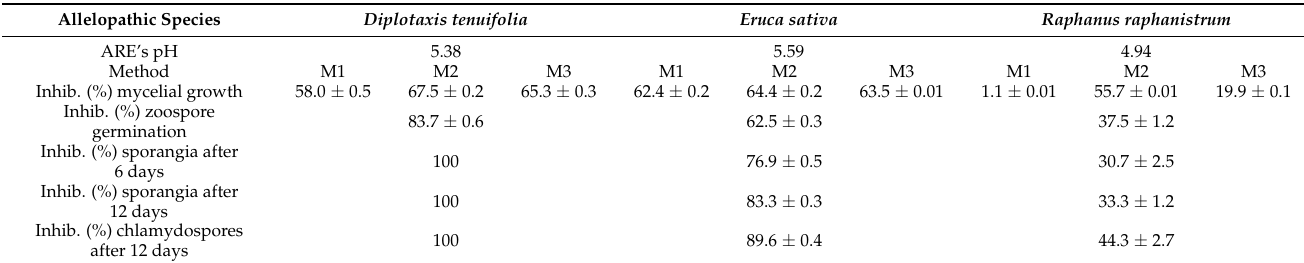
Table 1. Allelopathic effects of AREs on Phytophthora cinnamomi structures (percentages are the mean and standard errors of six replicates per method and species).